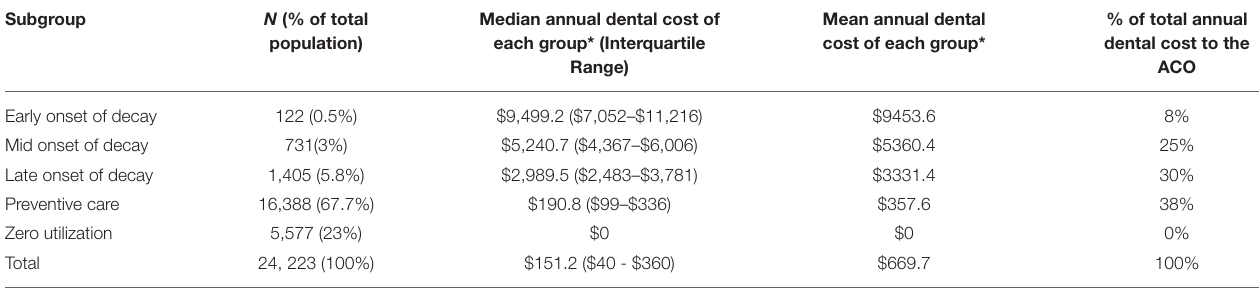
TABLE 2 | Median and mean annual dental cost by five subgroups of PFK children who had continuously enrolled in Ohio Medicaid from age 24–60 months (Total N = 24,223). Subgroup